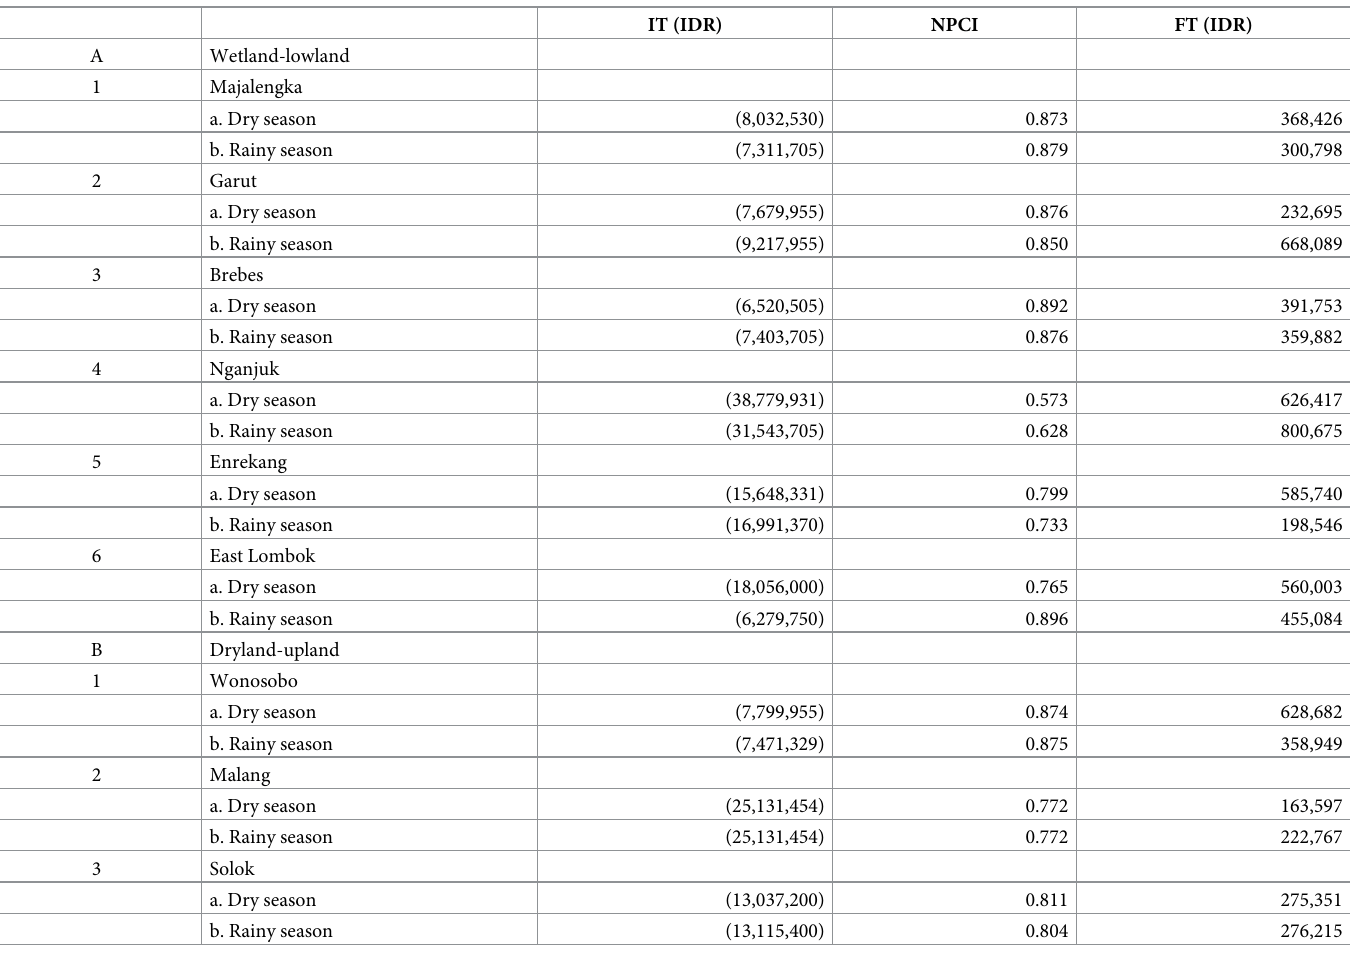
Table 5. Values of IT, NPCI, and FT of shallot farming per ha per season in Indonesia’s shallot production centers, dry season 2019 and rainy season